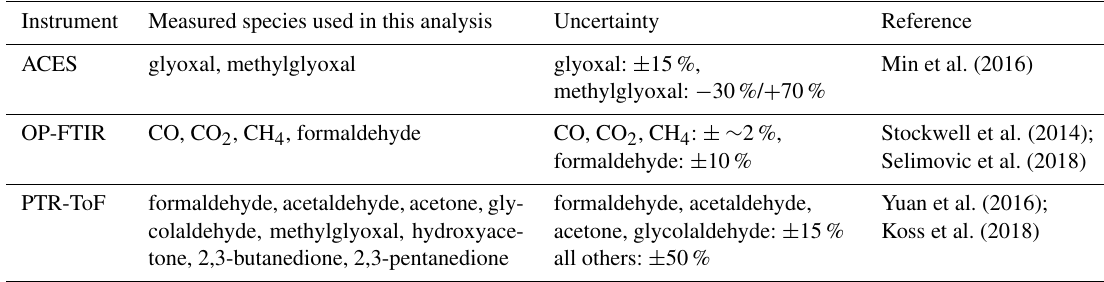
Table 1. Details of the measurements and instruments used in this work. All three instruments can measure additional species not used in this